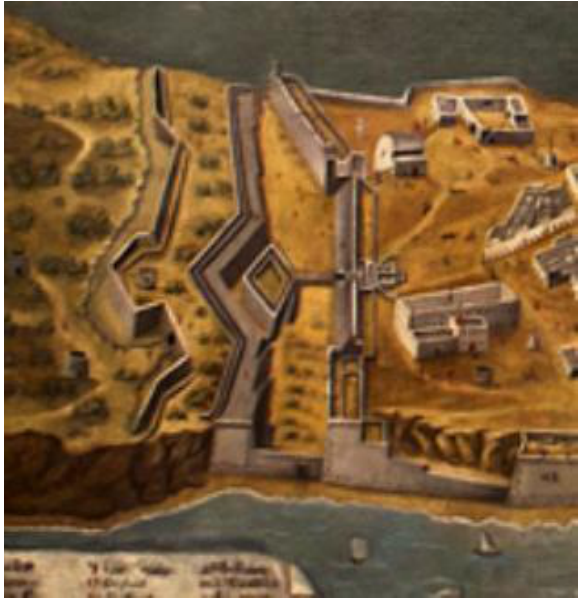
Figure 6. Detail of the one known as “Vista Arámburu” where the fortification of the Land Front appears with the “Work crowned” in a view of Cadiz from the end of the 17th century.